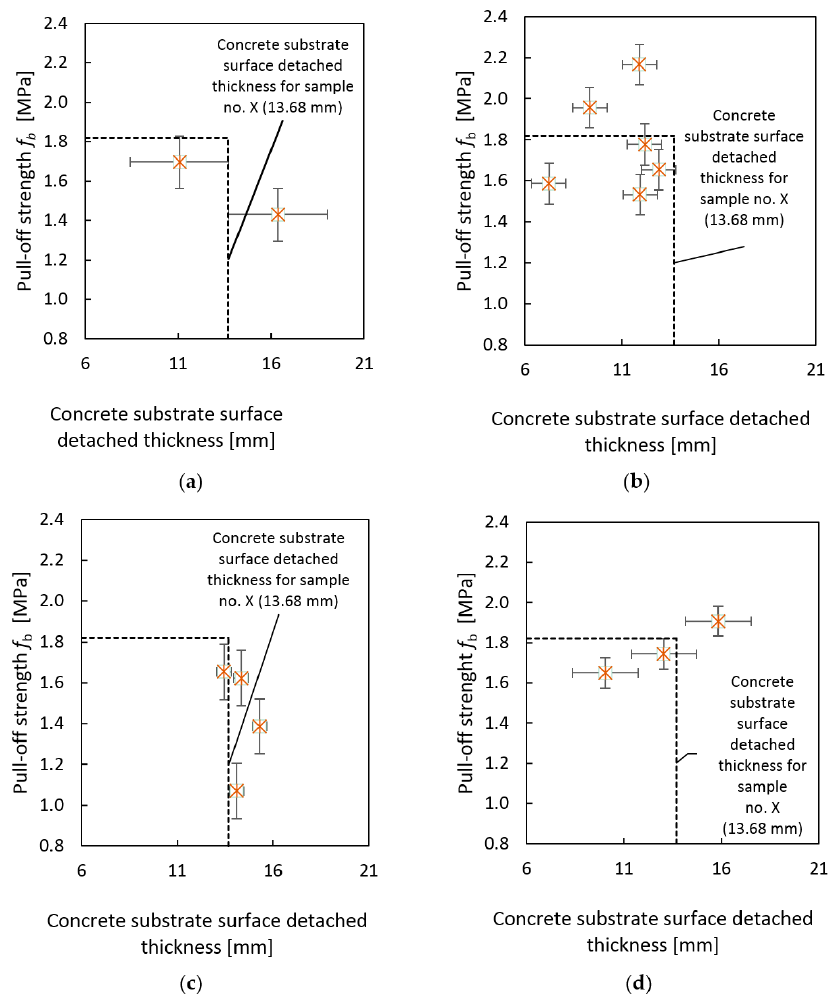
Figure 10. Impact of concrete substrate surface detached thickness on the pull-off strength of the epoxy resin coating for: ( a ) grooving (samples from 1 to 2); ( b ) imprinting (samples from 3 to 8); ( c ) patch grabbing (samples from 9 to 12); ( d ) brushing (samples from 13 to 15).